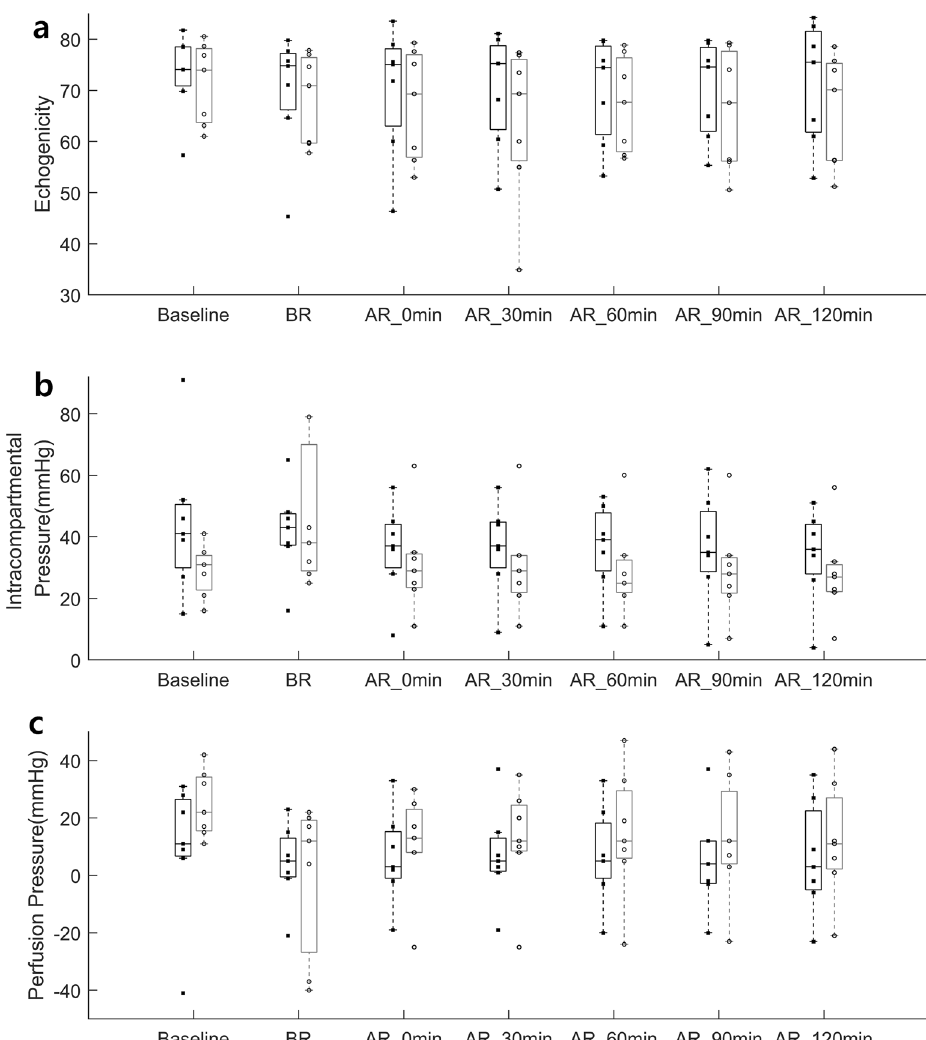
Figure 2. (a) Echogenicity, (b) intracompartmental pressure, and (c) perfusion pressure between the experimental leg (black bar plot) and the control leg (gray bar plot) at each time point (Baseline, BR, AR_0 min, AR_30 min, AR_60 min, AR_90 min, and AR_120 min). Each dot indicates each data point in each group. Each bar plot indicates 25th (Q1), 50th (Q2), and 75th (Q3) percentiles of the data. The whisker indicates Q3 + 1.5 × (Q3–Q1), and Q1 − 1.5 ×